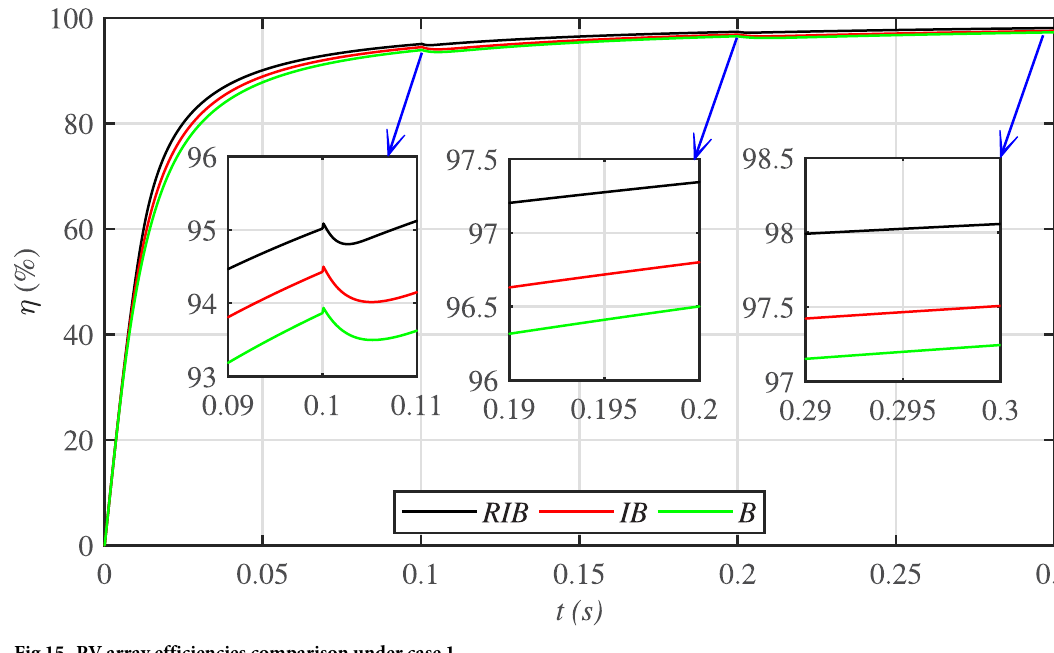
Fig 15. PV array efficiencies comparison under case